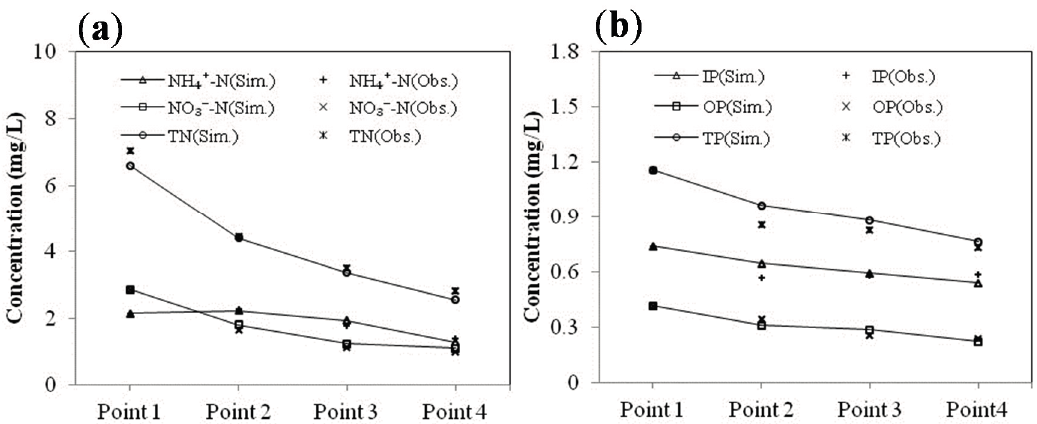
Figure 4. Water quality calibration results for the Tianlai River. ( a ). N indexes; ( b ). P